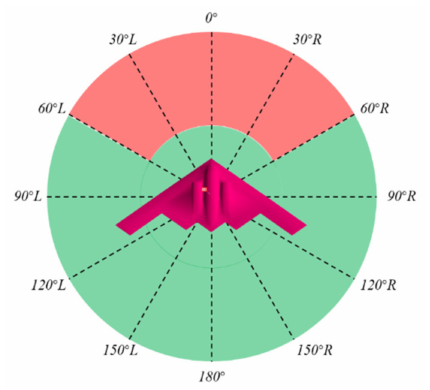
Figure 4. Top view of the attack